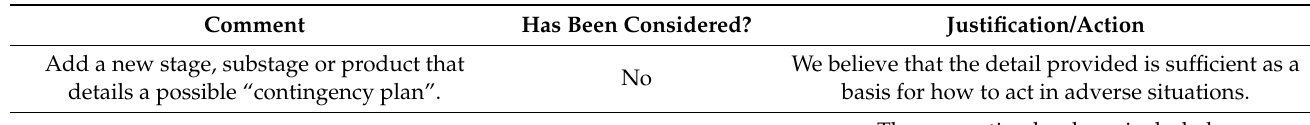
Table 5. Results of question